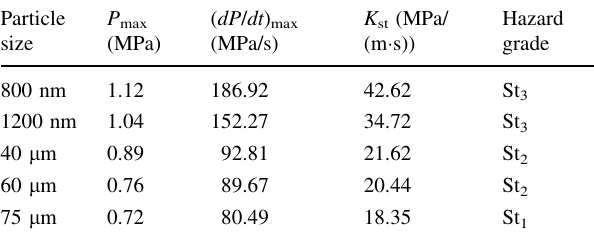
Table 4 Micro-nano methane–coal dust explosion characteristics and risk levels in the pipe